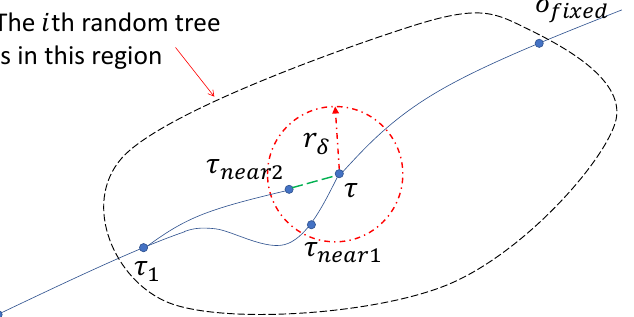
Figure 8. An illustration of shortening the i th sub-tour. Suppose in the feasible tour that the vertex τ connects to τ 1 via τ near 1 . τ near 1 and τ near 2 are inside the r δ neighbourhood of τ . If replacing the path from τ 1 to τ via τ near 1 using the path via τ near 2 results in a shorter completion time of the whole tour and the residual energy constraint is satisfied, we update the tour using the latter path via τ near 2 .